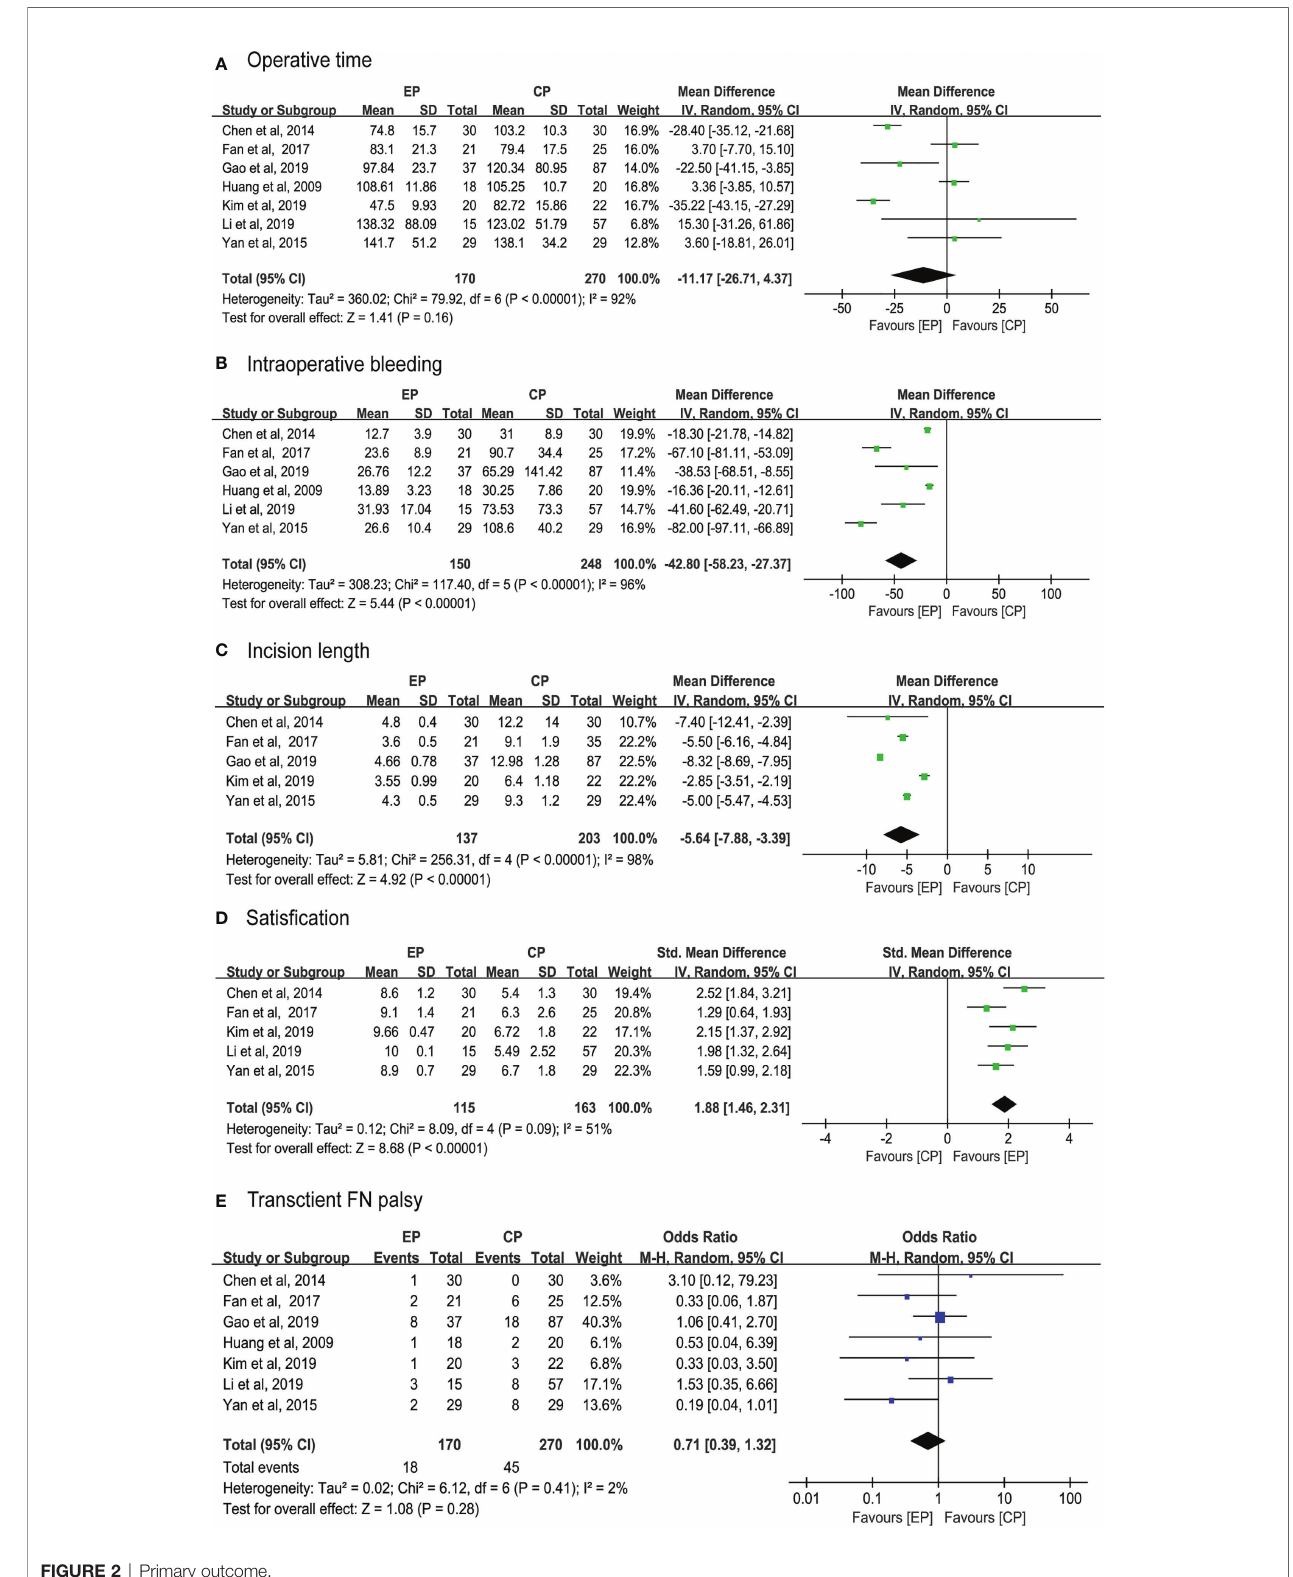
FIGURE 2 | Primary